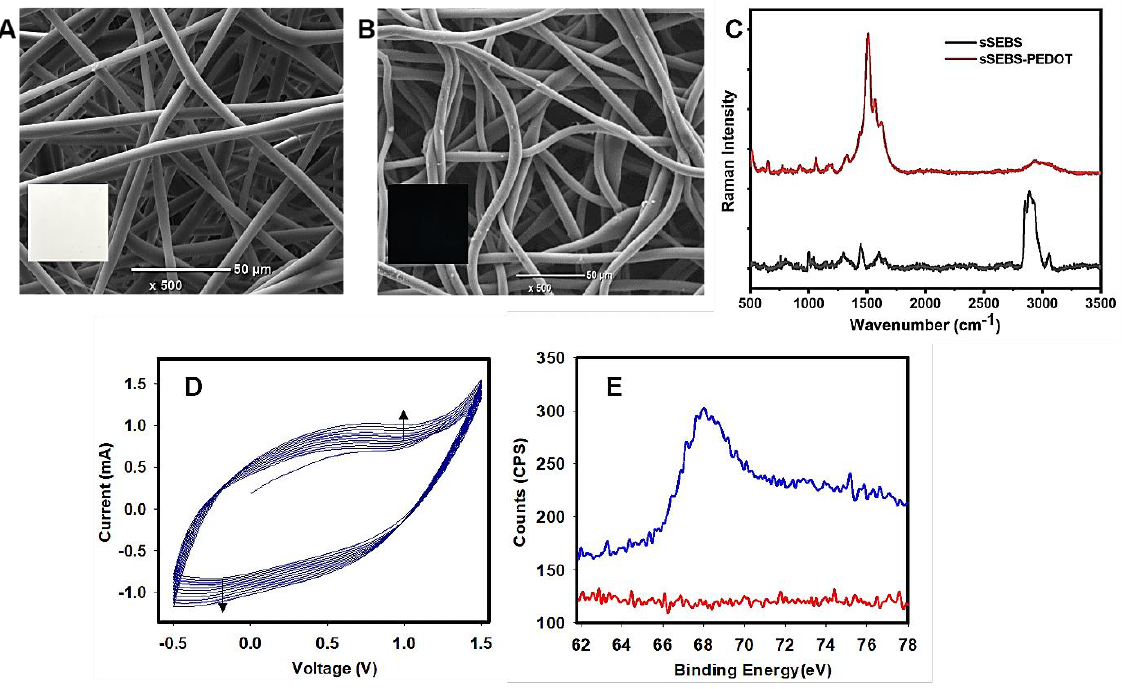
Figure 2. SEM images of ( A ) an electrospun sSEBS fibre mat (inset: photographs of sSEBS fibre mat), ( B ) PEDOT coated conducting electrospun fibre mat (sSEBS-PEDOT) (inset: photographs of sSEBS-PEDOT fibre mat), ( C ) Raman spectra of pristine and PEDOT coated electrospun sSEBS fibre mat, ( D ) Cyclic voltammograms of the electrodeposition of P(EDOT -co- EDOTBr) (10:1 mol:mol) onto sSEBS-PEDOT in the potential range of -0.5 V to +1.5 V at 100 mV/s for 10 cycles, in 0.1 M LiClO 4 in acetonitrile, and ( E ) XPS spectra of Br 3d of sSEBS-PEDOT fibre mat (red) and sSEBS-PEDOT/P(EDOT -co- EDOTBr) fibre mat (blue).